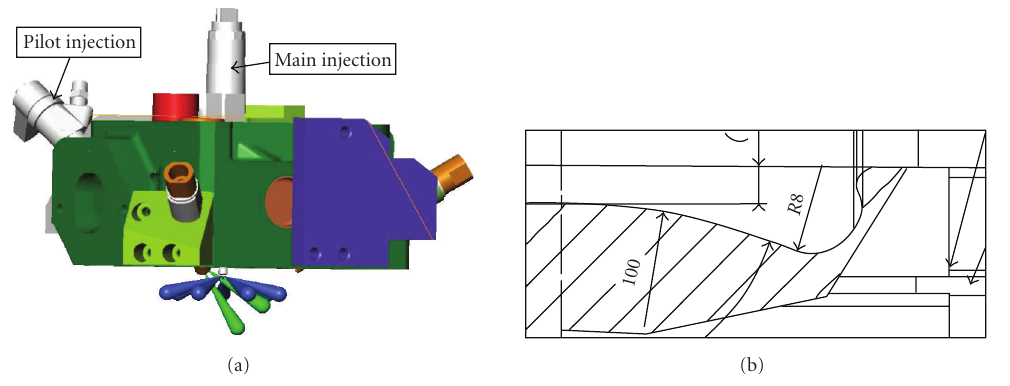
Figure 5: Cylinder head CAD-model and ω -bowl in piston.